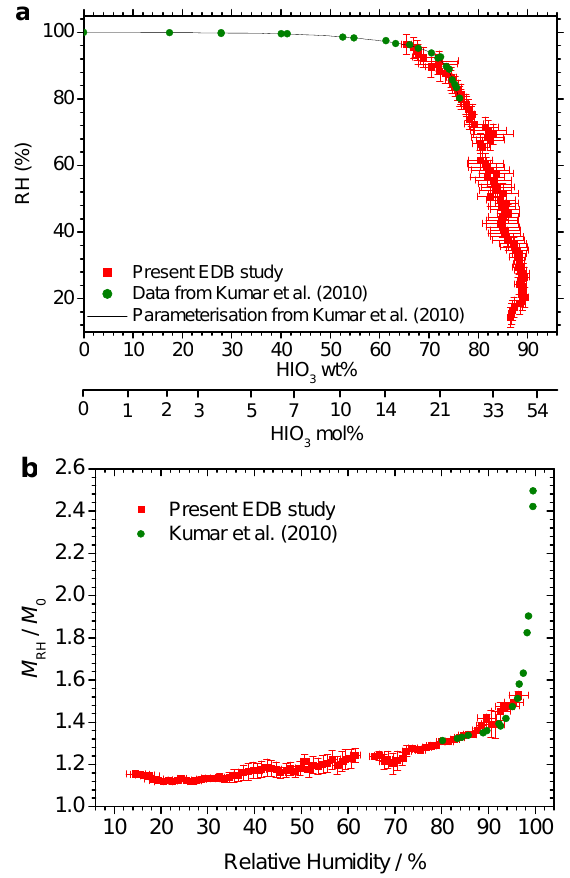
Fig. 9. (a) Variation of solute mass concentration as a function of RH. Direct measurements of water activity of solutions of known composition were taken from Kumar et al. (2010) and the data for lower RH was determined using the measured EDB growth factor. The growth factor data were translated into concentration by relat- ing the data at 83.8% RH where the concentration is well known. We use the formula (rearranged from the caption to Fig. 8): C RH = C ∗ GF ∗ /GF RH , where C ∗ = 75 . 32% and GF ∗ = 1 . 16. We have not been able to find a satisfactory empirical fit to describe this data, in- stead the data is included as supporting material (“wt% vs RH.cvs” and “EDB RH vs GF.cvs”). (b) The same data as in (a) , but pre- sented as M RH / M 0 , where M 0 is the mass of the dry iodic acid (HIO 3 ) . This is the growth factor referenced to the dry mass (GF 0 ) rather than the observed mass at low RH in Fig. 8a. Note that the GF 0 does not tend to 1.0, but remains at a higher value due to re- tained water in the ultra-viscous or glassy